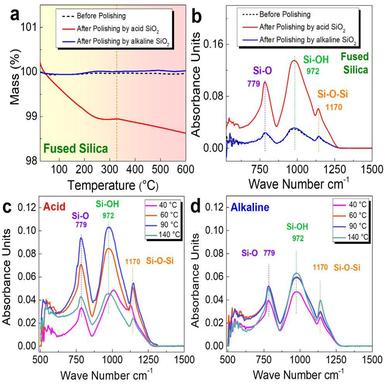
Comparison of analysis on FS: (a) TGA curves and (b) IR spectra of FS before and after 6 h polishing by acid and alkaline SiO2 slurries, the IR spectra was achieved at room temperature; IR spectra of FS soaked in (c) acid SiO2 slurry and (d) alkaline SiO2 slurry for 6 h at different temperatures. The scales of Y-axes for (c) and (d) have been combined for comparison.